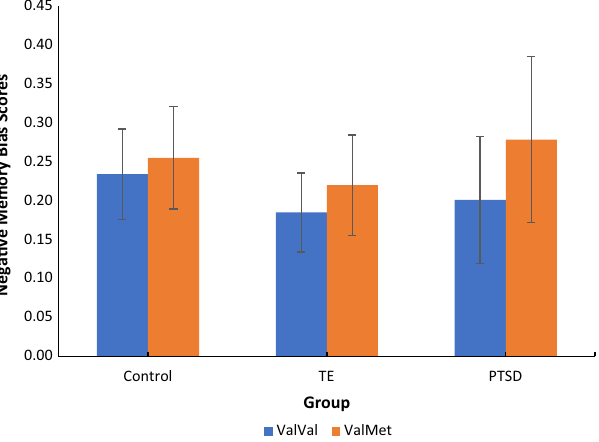
Figure 3. Mean negative bias scores for BDNF genotype across the PTSD, TE and control groups. Error bars: 95% confidence